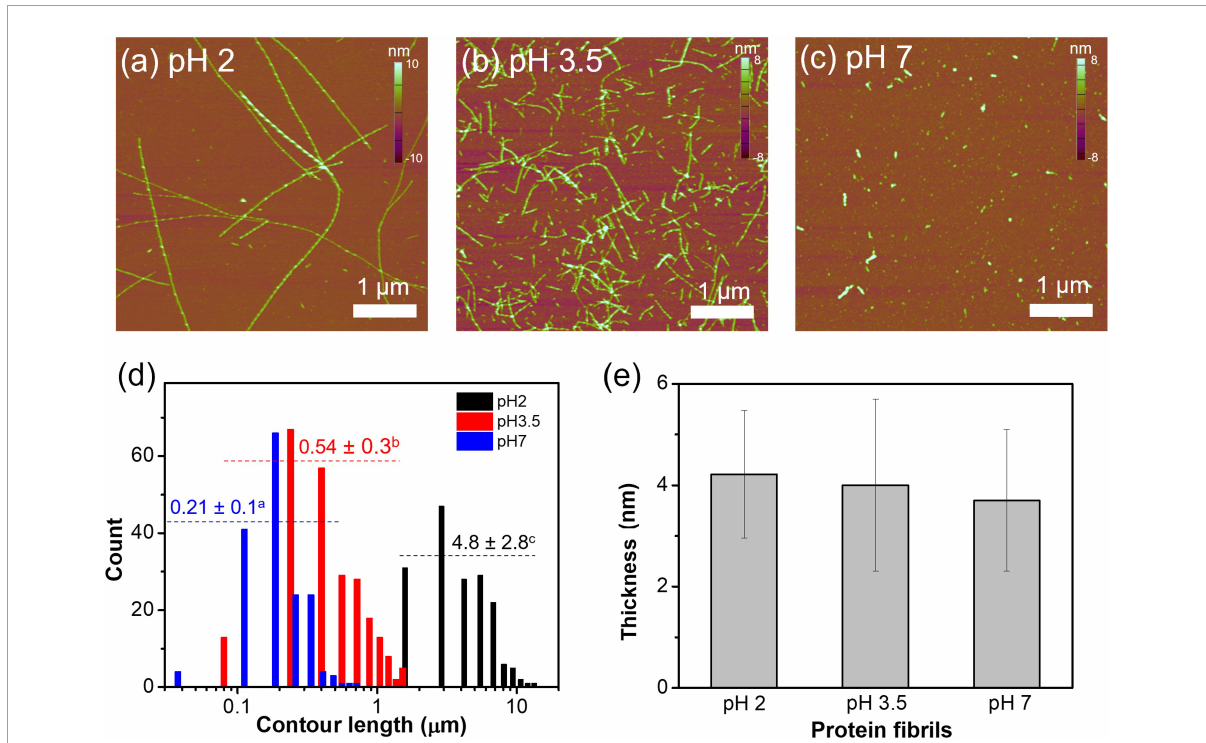
FIGURE1 Morphological characteristics of whey protein fibrils at pH 2, 3.5, or 7. (a–c) AFM micrographs of whey protein fibrils at pH 2, 3.5, and 7. Fibril heights are denoted in the color bars on the right of each graph. (d) Contour length distribution of whey protein fibrils at different pH levels. The number above the dotted line represents mean ± standard deviation of the fibril contour length, and the different letters on the top right represent that the values are significantly different. (e) The mean and standard deviation of the thickness of protein fibrils prepared at different pH levels.